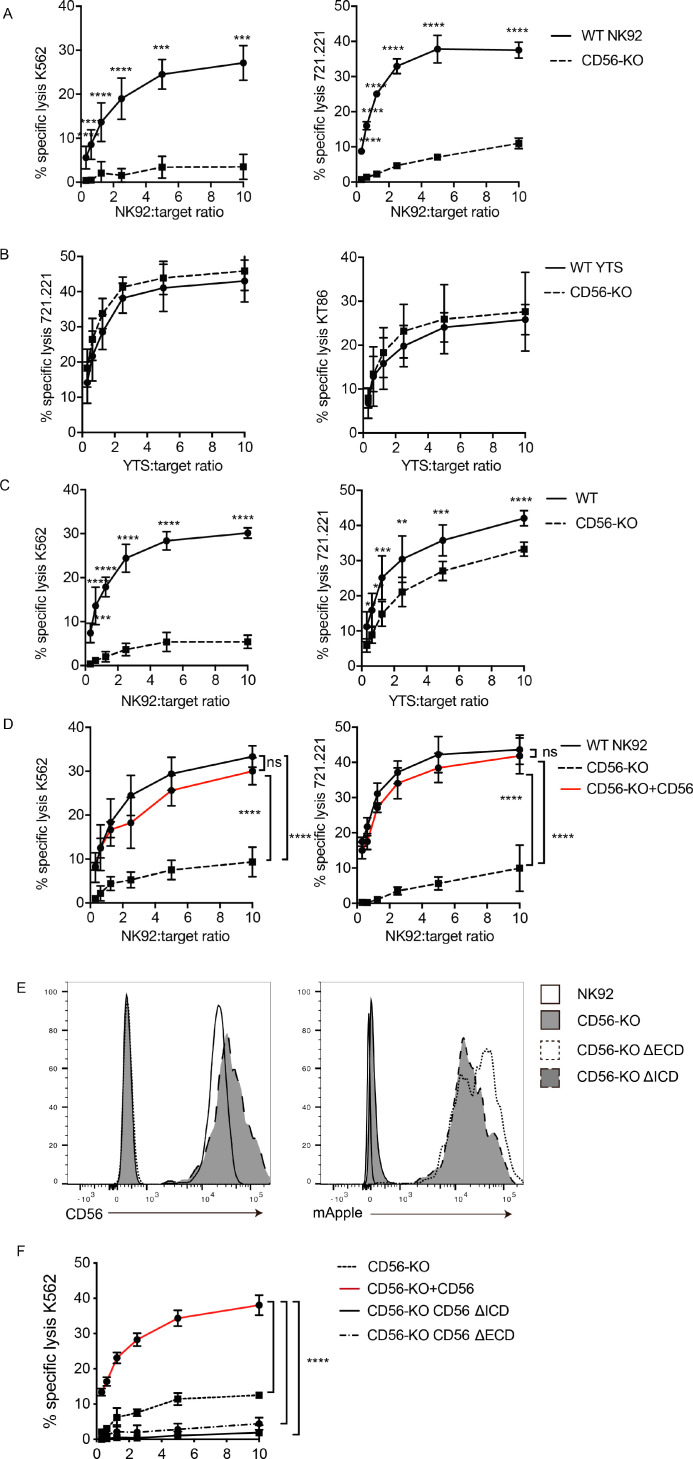
CD56 deletion abrogates NK92 cytotoxic function and delays YTS cytotoxicity.51Cr-release assays were performed using NK92 (A, C, D) or YTS (B, C) WT and CD56-KO cell lines as effectors against susceptible targets. (A) 4 hr assays were performed with NK92 cell lines using K562 (left) or 721.221 (right) target cells. (B) 4 hr assays were performed with YTS cell lines using 721.221 (left) or KT86 (right) target cells. (C) 1 hr 51Cr-release assays were performed using NK92 (left) or YTS (right) cells as effectors. (D) CD56 (NCAM-140) was re-expressed in NK92 CD56-KO cells and these cells, NK92 or NK92 CD56-KO cells were used for 4 hr cytotoxicity assays against K562 (left) or 721.221 (right) target cells. (E) CD56-KO NK92 cells were transfected with chimeric CD56 constructs fused to an mApple fluorescent reporter as described in Materials and methods. Flow cytometry was used to confirm the expression of CD56 and/or mApple. (F) Cytotoxicity assays were performed with chimeric cell lines using K562 cells as targets. Mean ± S.D. of three independent experiments pooled. **p<0.01, ***p<0.001, ****p<0.0001 by Ordinary one-way ANOVA with multiple corrections test or unpaired student t-test with Welch’s correction. ΔECD: chimeric construct lacking extracellular domain, ΔICD: chimeric construct lacking intracellular domain.